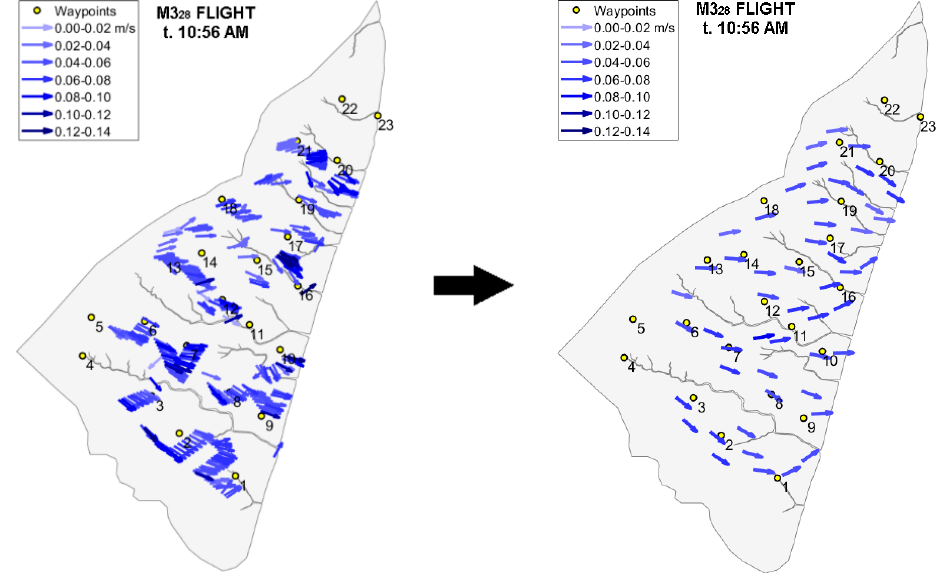
Figure 8. The instantaneous velocities calculated over the marsh (left) are filtered by removing the values close to the creeks and interpolated over the marsh area. This results in a surface water velocity field with a spatial resolution of ~60 m (right).